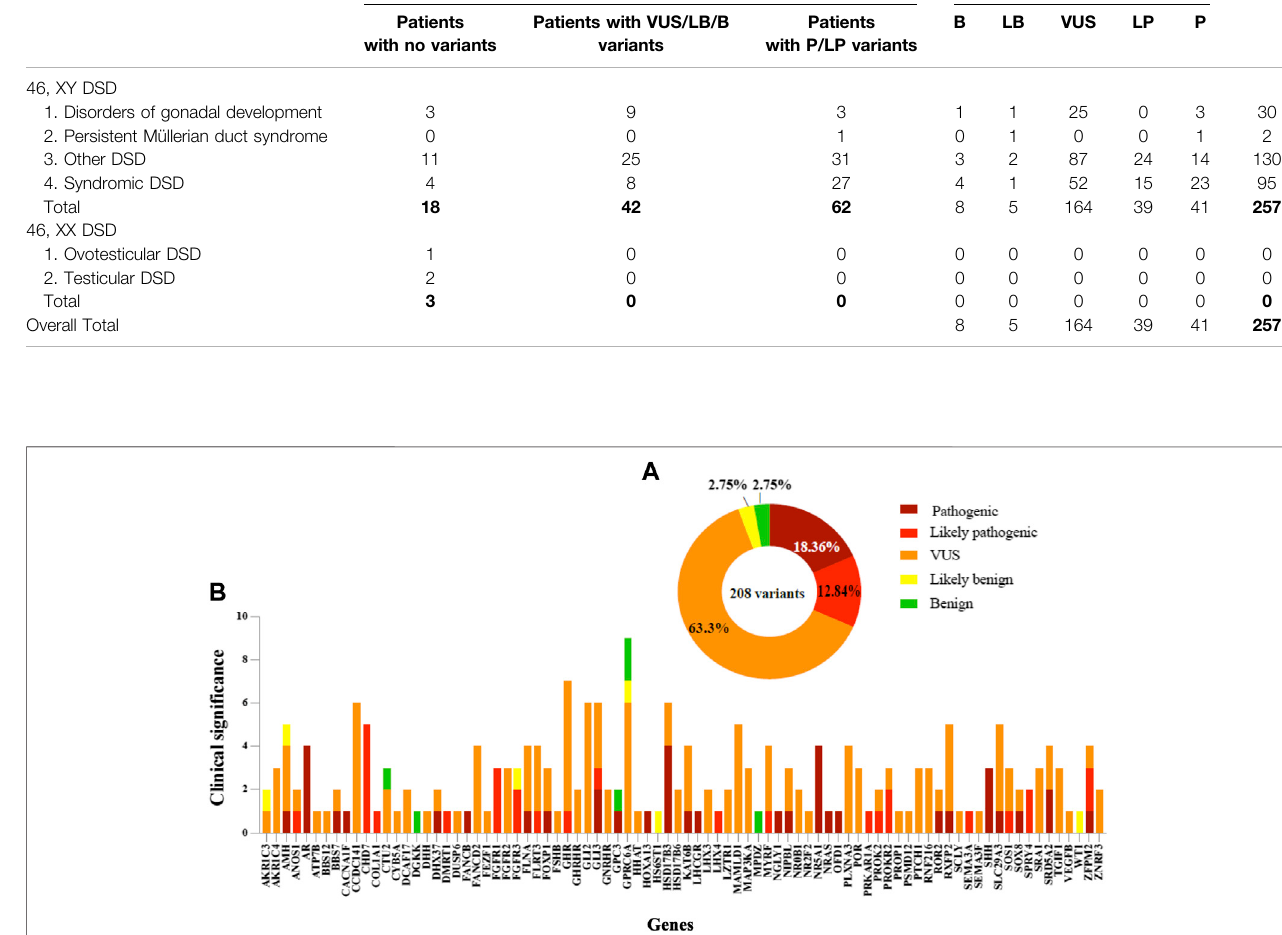
TABLE 4 | Distribution and characteristics of pathogenicity in curated 256 variants in cohort of 125 patients with syndromic/non-syndromic DSD phenotypes. Cohort classi fi cation Patients grouped according to variant class Number of variants Total Patients Patients with VUS/LB/B Patients with no variants variants with P/LP variants